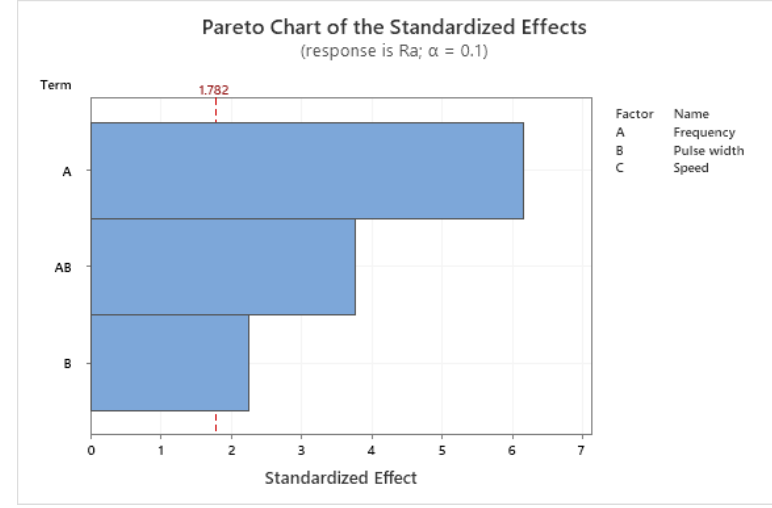
Figure 3. Pareto Chart of the Standardized Effects for Ra.